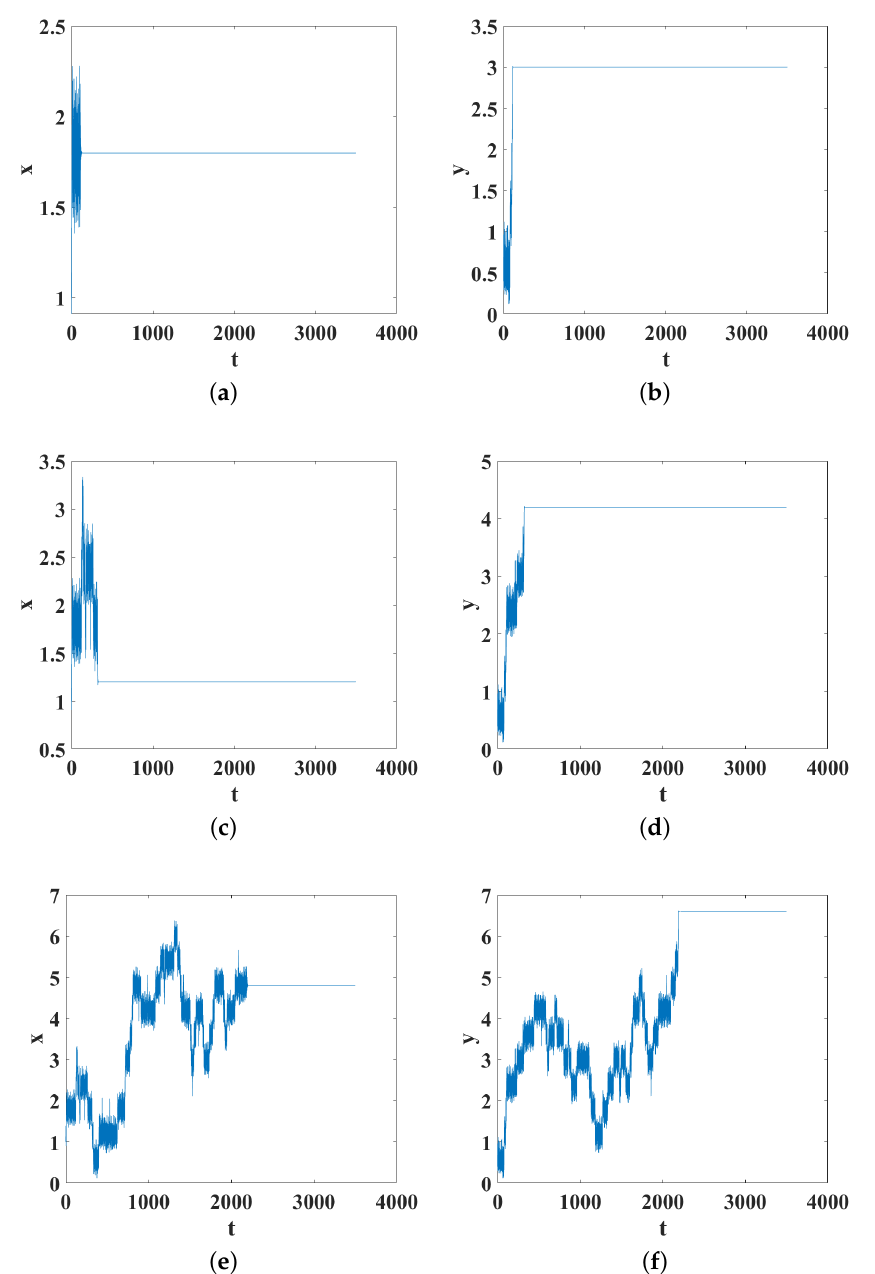
Figure 5. Times of particle settling for a fixed initial condition and different values of the dispersion medium size. ( a , b ) m = 4; ( c , d ) m = 6; ( e , f ) m = 10. In Figure 6, the settlement of the particles at the edge of the dispersion medium is shown on a color map. The colors correspond to the final positions of the particle along the x -axis for a fixed initial condition and size of the dispersion medium (m), and the other parameters previously analyzed are varied. The region of color with the highest trend determines the point of attraction of the